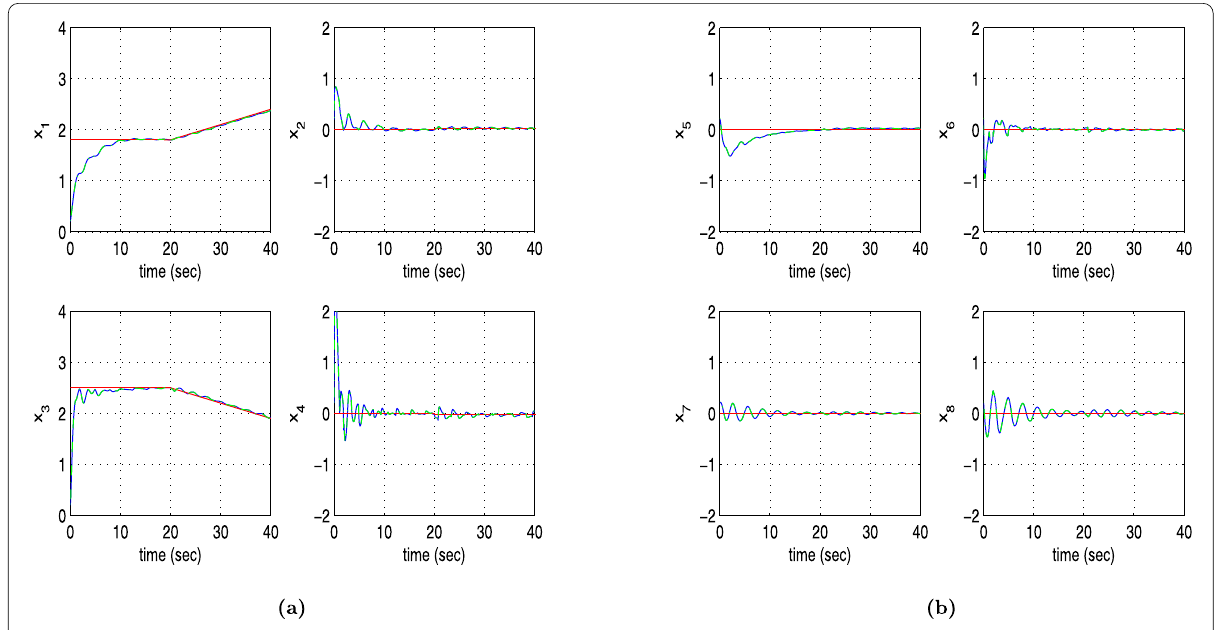
Figure 10 Tracking of setpoint 4 for the tower crane ( a ) control inputs u 1 , u 2 applied to crane, ( b ) tracking error variables e 1 , e 3 , e 5 , e 7 of the tower crane